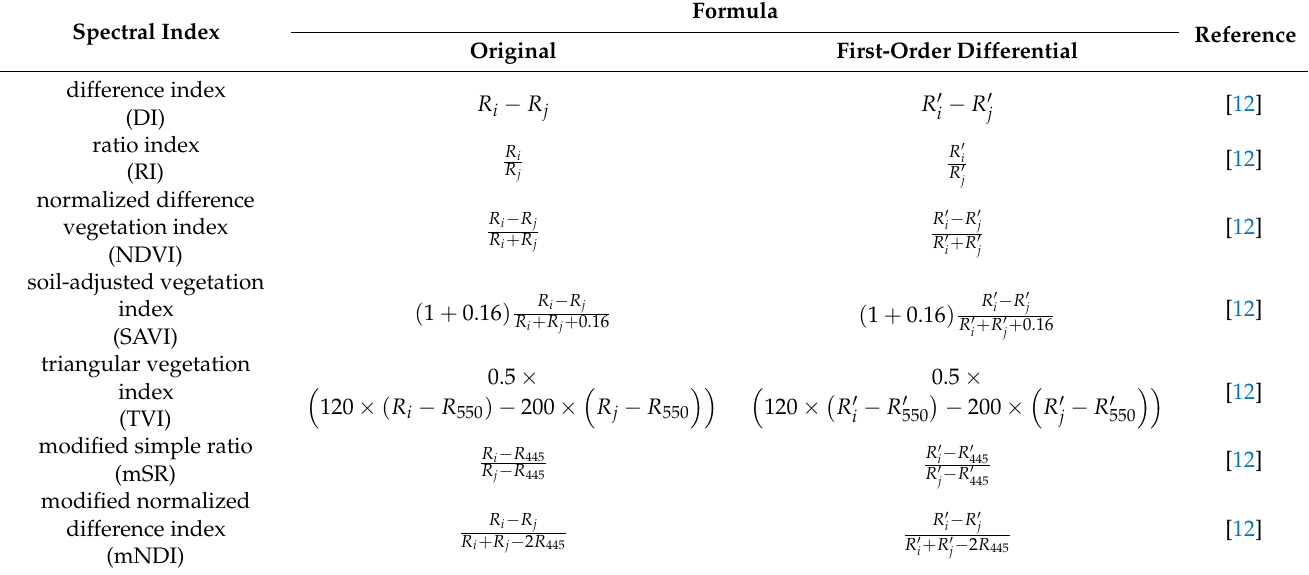
Table 2. Spectral index in this study. All indices were calculated from reflectance collected by spectroradiometer. i and j represent arbitrary wavelength positions, R and R represent the original wavelength positions of i and j . The initial spectral reflectance, R ’ and R ’ represent the first-order differential spectrum at the i and j wavelength positions Spectral reflectance, R 445 and R 550 represent the original spectrum at 445 and 550 nm wavelength positions spectral reflectance, R ’ 445 and R ’ 550 represent the first order at the 445 and 550 nm wavelength positions differential spectral